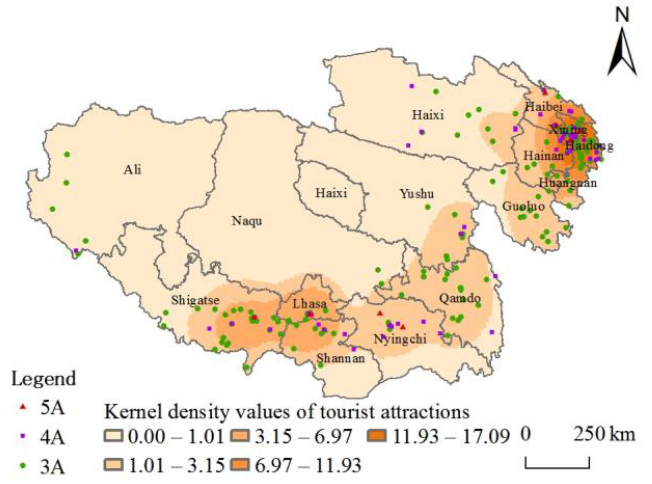
Figure 3. Standard deviation characteristics.